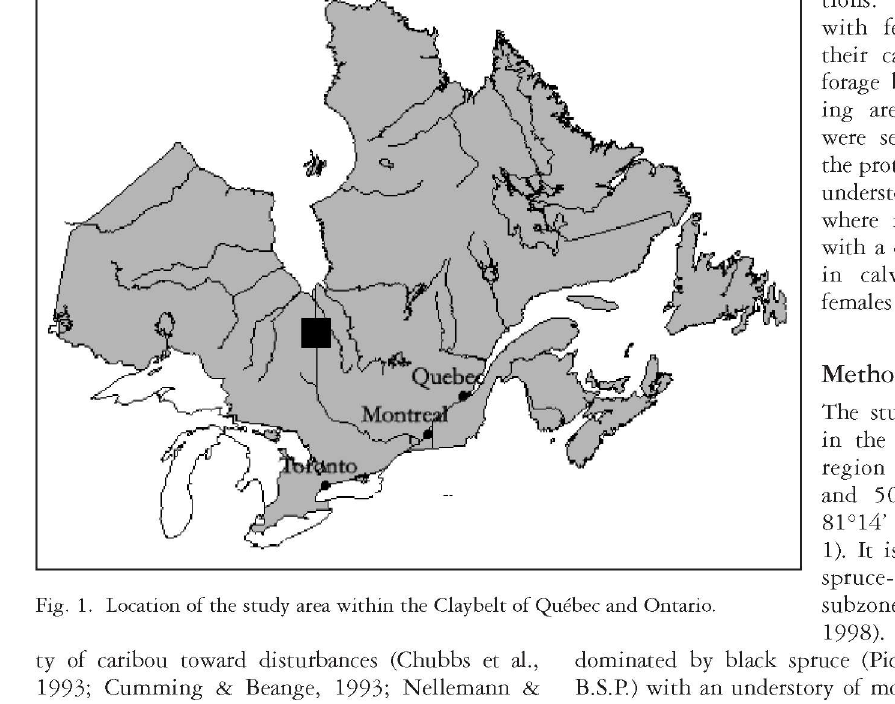
Fig. 1. Location of the study area within the Claybelt of Québec and Ontario. ty of caribou toward disturbances (Chubbs et